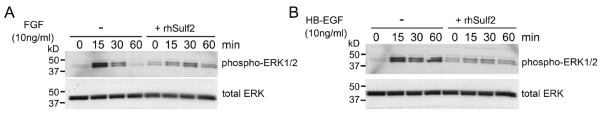
Recombinant human Sulfatase 2 inhibits growth factor-induced ERK activation. MDA-MB-231 cells were treated with 250 nM rhSulf2 for 24 h prior to FGF (A) or HB-EGF (B) stimulation. Cell lysates were collected before growth factor addition (0 min), or 15, 30, and 60 minutes after addition for analysis of phospho-ERK1/2 and total ERK. The two phosphorylated p44 and p42 species of ERK are detected using phospho-ERK1/2 antibodies.